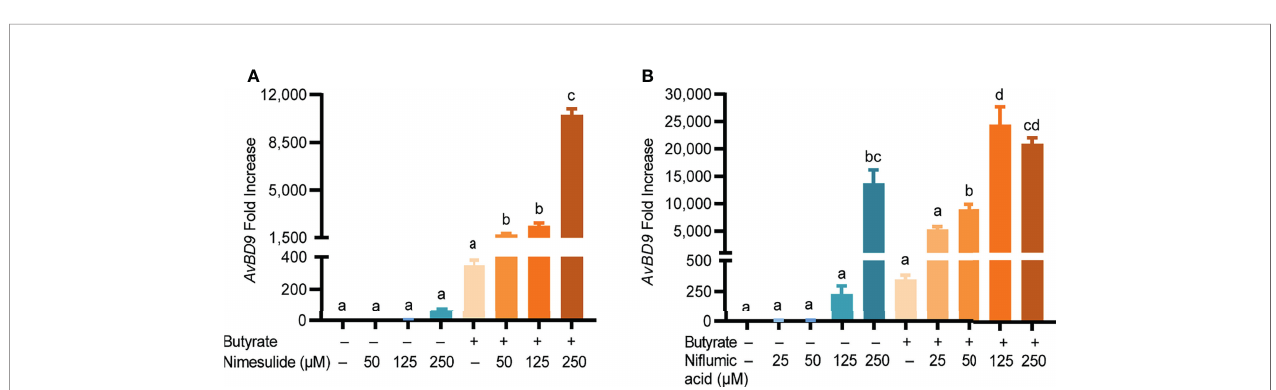
FIGURE 6 | Synergistic induction of AvBD9 gene expression by synthetic COX-2-speci fi c inhibitors and butyrate. Chicken PBMCs were treated in duplicate with indicated concentrations of nimesulide (A) or ni fl umic acid (B) with or without 2 mM butyrate for 24 h, followed by RT-qPCR analysis of AvBD9 gene expression. Results are presented as means ± SEM of two independent experiments. The bars not sharing common superscript letters are signi fi cantly different ( P < 0.05) as determined by one-way ANOVA and post hoc Tukey ’ s test.